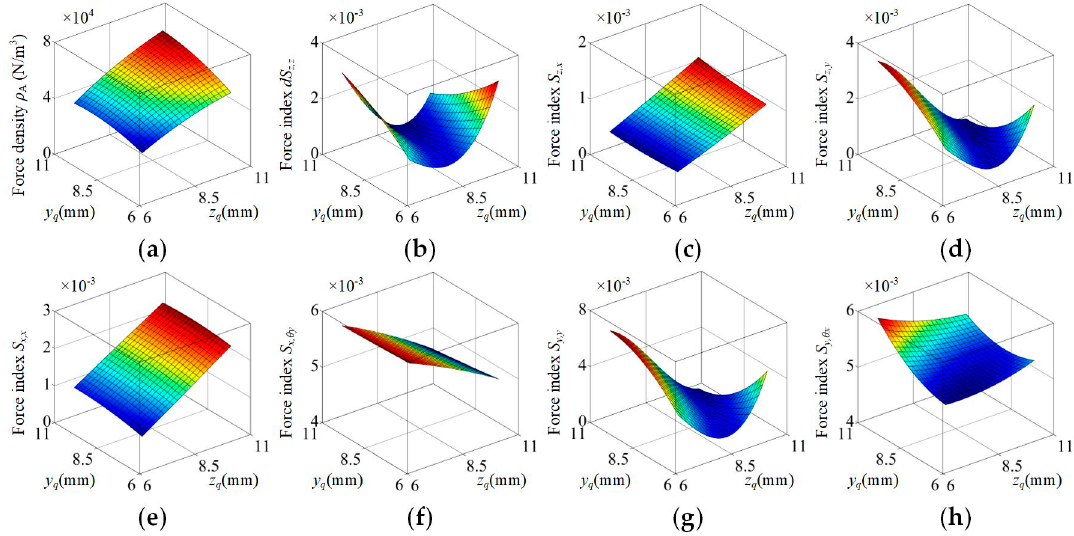
Figure 12. Force density and uniformity of the HMF-VCA varied with structural parameters y q and z q . ( a ) Force density ρ A . ( b ) Variation of F z caused by z . ( c ) Variation of F z caused by x . ( d ) Variation of F z caused by y . ( e ) Variation of F x caused by x . ( f ) Variation of F x caused by θ y . ( g ) Variation of F y caused by y . ( h ) Variation of F y caused by θ x .